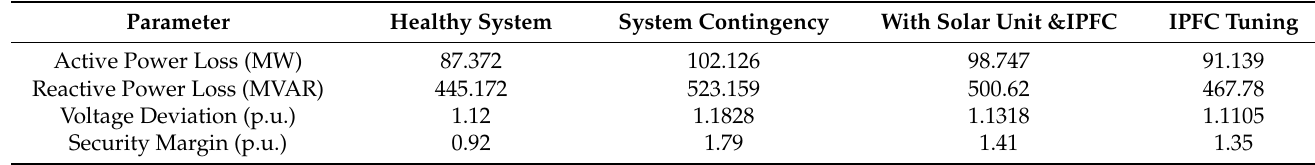
Table 3. Comparison of parameters of integrated system under various conditions.